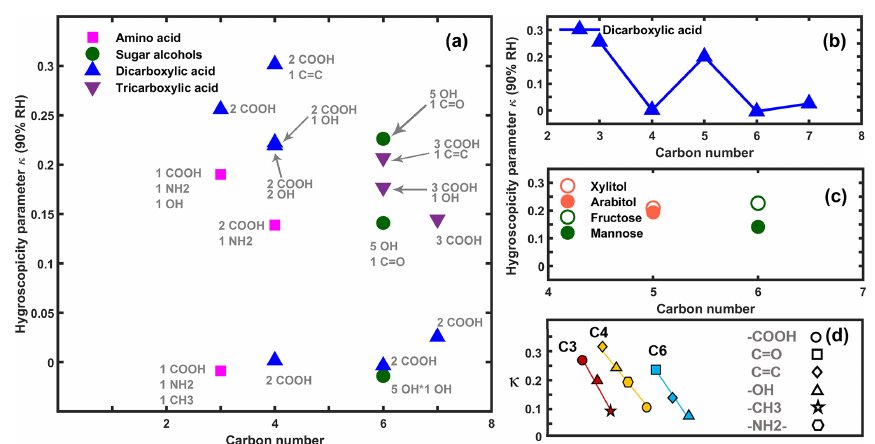
Figure 5. Hygroscopicity of organics as a function of carbon number (a) , hygroscopicity of dicarboxylic acids vs. carbon number (b) , hygroscopicity of isomers (c) , and organic hygroscopicity as a function of functionality with the same carbon number (d) .